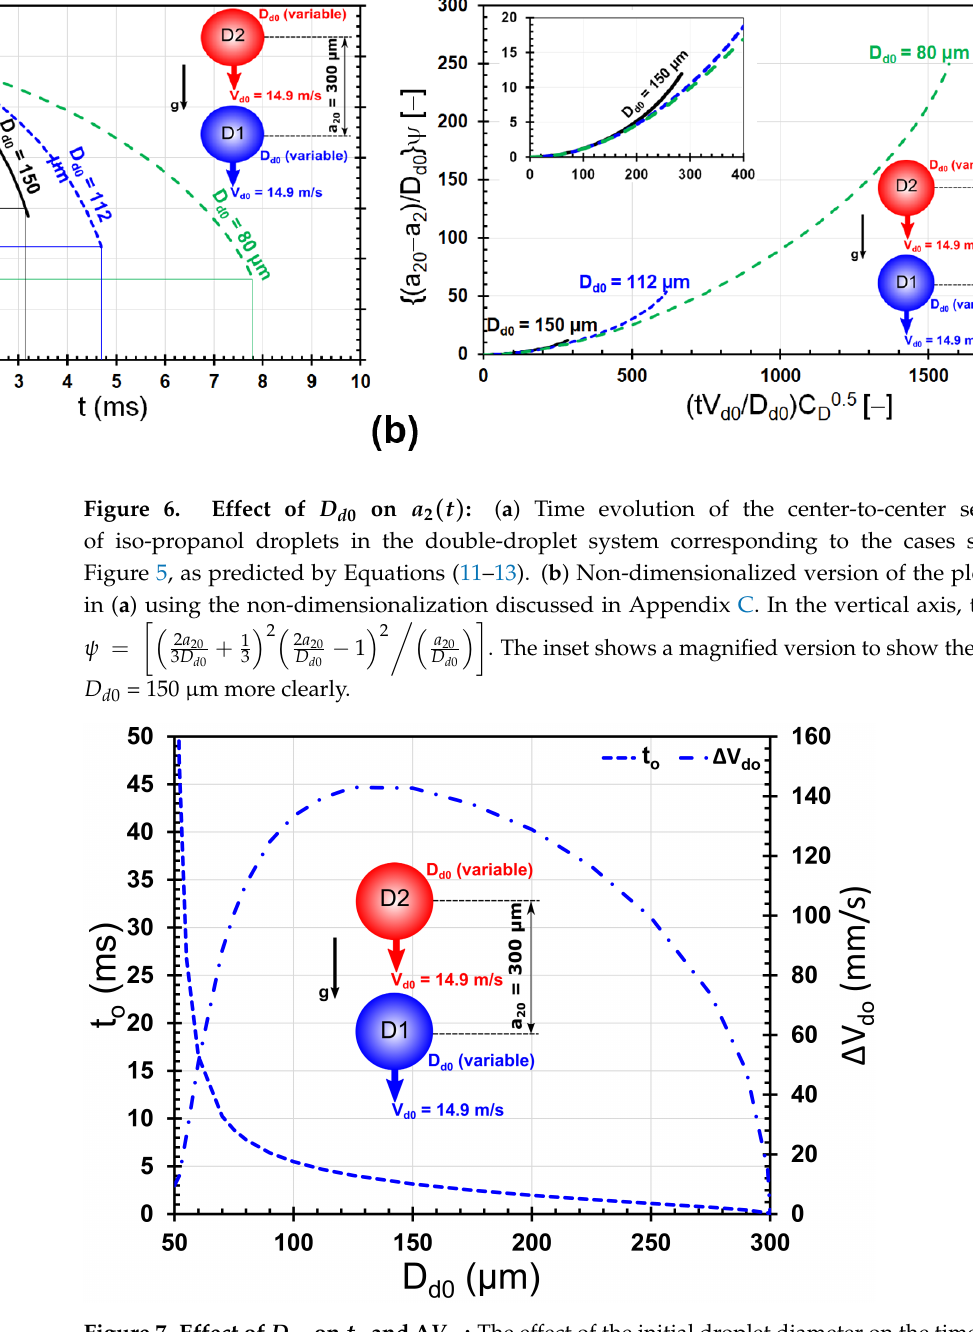
Figure 7. Effect of D d 0 on t o and ∆ V d 0 : The effect of the initial droplet diameter on the time taken by the droplets to come in contact with each other for the first time and their approach velocity at this instant. Other parameters are the same as in Figure 4: a 20 = 300 µ m; V d 0 = 14.9 m/s; C D is calculated using Equation (10). The ranges of the initial values of the Reynolds number and aerodynamic Weber number are 49.4–296.4 and 0.61–3.68,